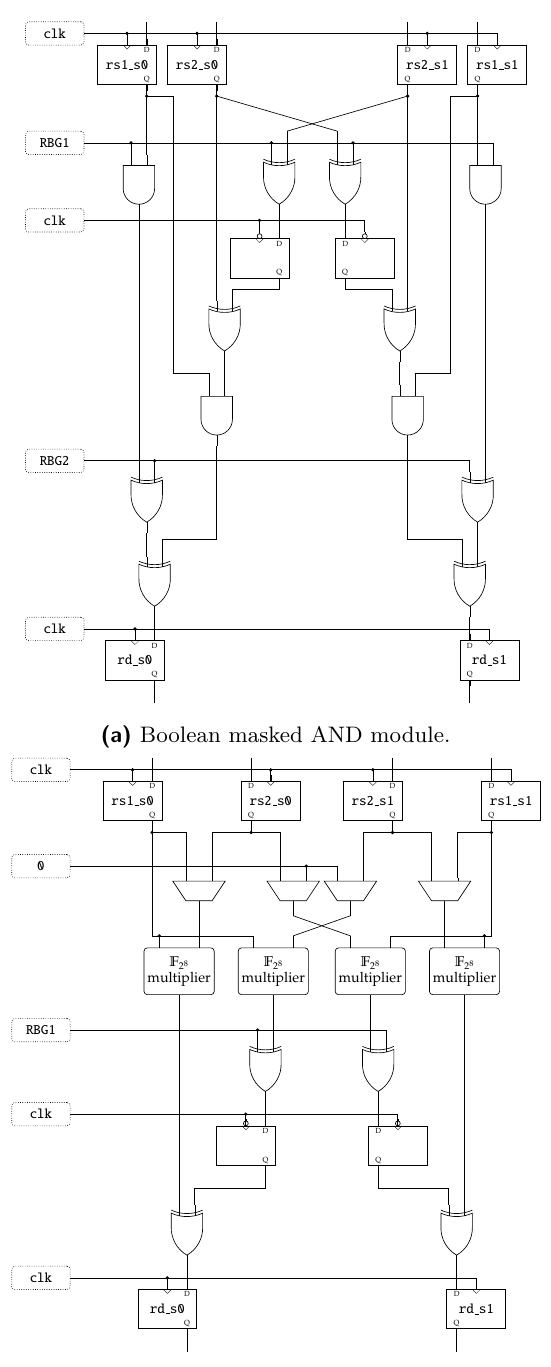
Figure 2: Two circuit diagrams which capture the DOM-based implementation of selected operations: note 1) the inclusion of remasking steps, and 2) double-pumped approach to clocking, whereby the input and output (resp. latching step) registers are enabled by positive (resp. negative) clock